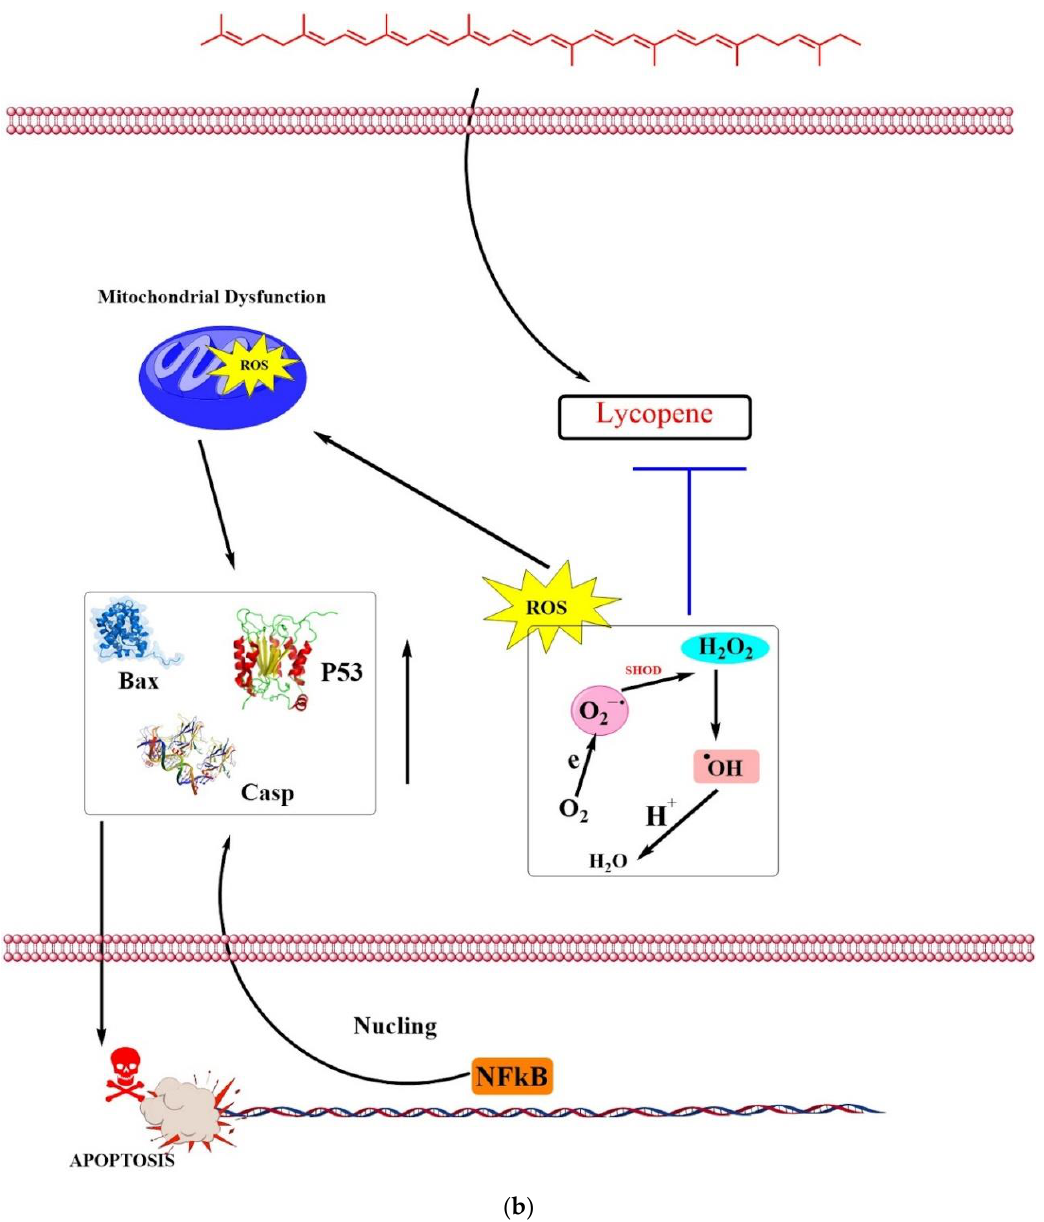
Figure 2. ( a ). Effect of lycopene on PDGFR-, IGF-IR-, and VEGFR-mediated signal pathways. ( b ) Effect of Lycopene on Reactive Oxygen Species (modified from [146]). of Lycopene on Reactive Oxygen Species (modified from